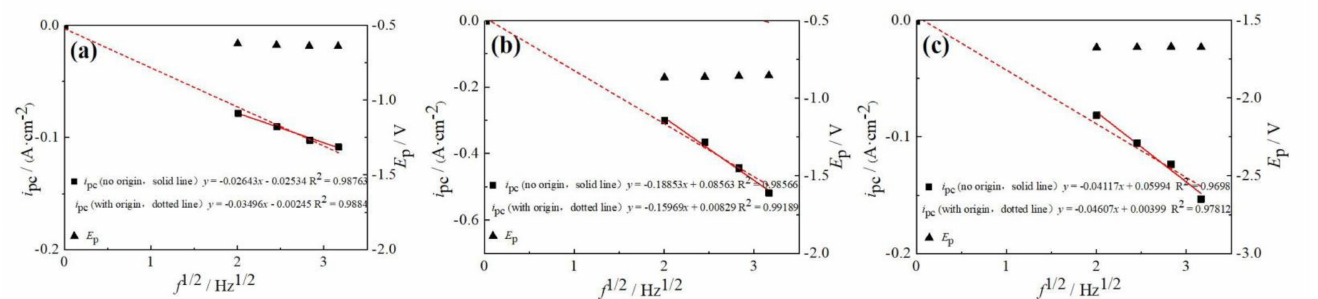
Figure 7. Correlation between peak current ( i pc ), peak potential ( E pc ) and square root of formula ( f 1/2 ) of ( a ) peak A, ( b ) peak B and ( c ) peak